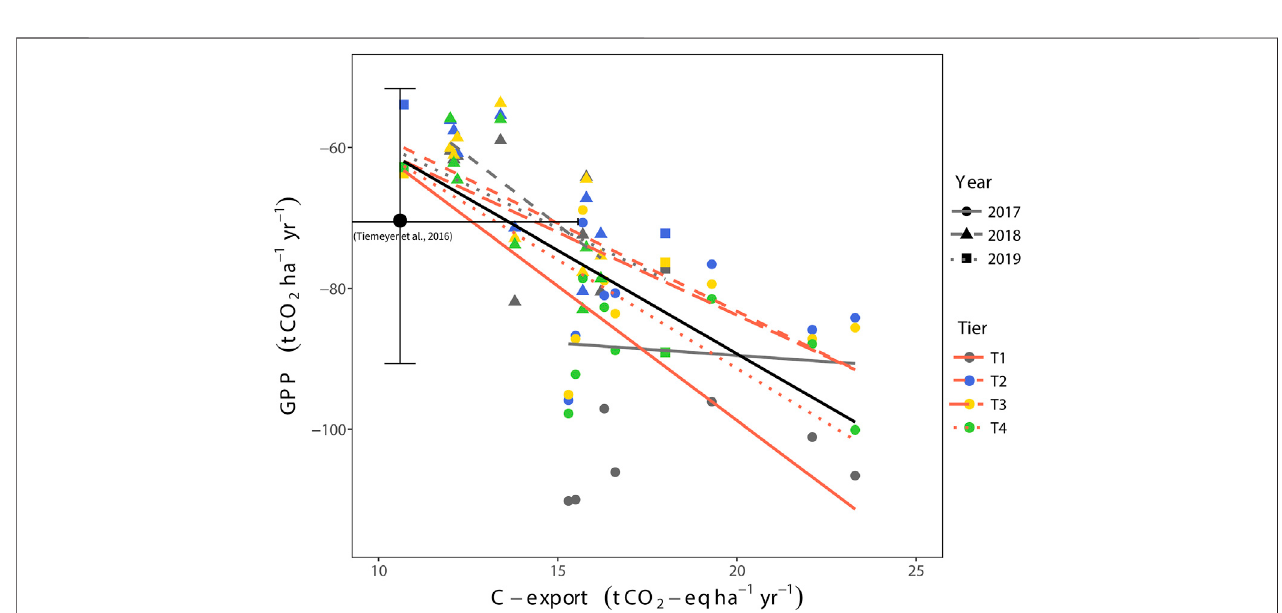
FIGURE5| IndirectvalidationbycomparingderivedannualGPPwithC-exportpermethodTierandyear.Theblacksolidlineistheresultofgenerallinearregressionof theentiredataset( p < 0.001, R 2 =0.42).Greylinesareregressionlinesperyear(2017, p =0.598, R 2 ~0;2018, p < 0.001, R 2 =0.52;2019, p =0.007, R 2 =0.69).Redlinesare regressionlinespermethodTier(Tierone, p =0.002, R 2 =0.42;Tiertwo, p =0.002, R 2 =0.43;Tierthree, p =0.002, R 2 =0.0.42;Tierfour, p < 0.001, R 2 =0.38).Blackpoint with error bars represents average values of GPP and C-export from nutrient-rich deep-drained grassland adopted from Tiemeyer et al. (2016).